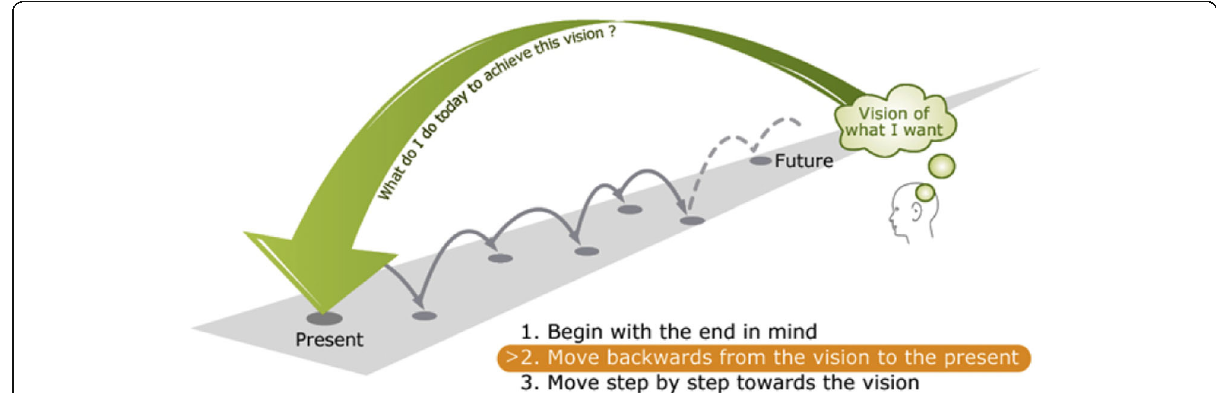
Fig. 1 The backcasting process from the natural step. Source: Holmberg